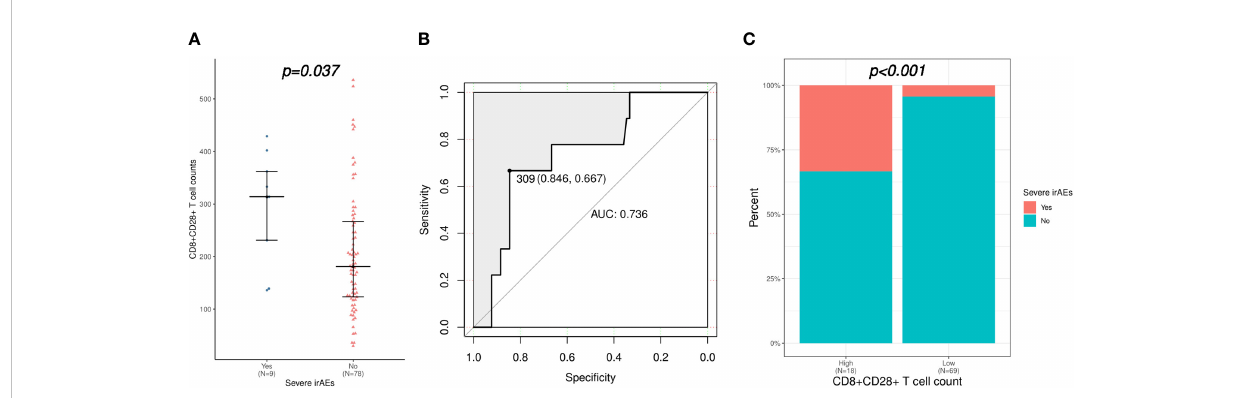
FIGURE 3 Correlation of CD8+CD28+ T-cell count with severe irAEs (irAEs of grade 3-4). (A) Comparison of CD8+CD28+ T-cell counts between patients with or without severe irAEs. (B) Validation of the predictive value of the CD8+CD28+ T-cell count for severe irAEs using an ROC curve. (C) Comparison of severe irAEs between patients with high ( ≥ 309 cells/ m L) and low (< 309 cells/ m L) CD8+CD28+ T-cell counts. irAEs, immune-related adverse events; ROC, receiver operating